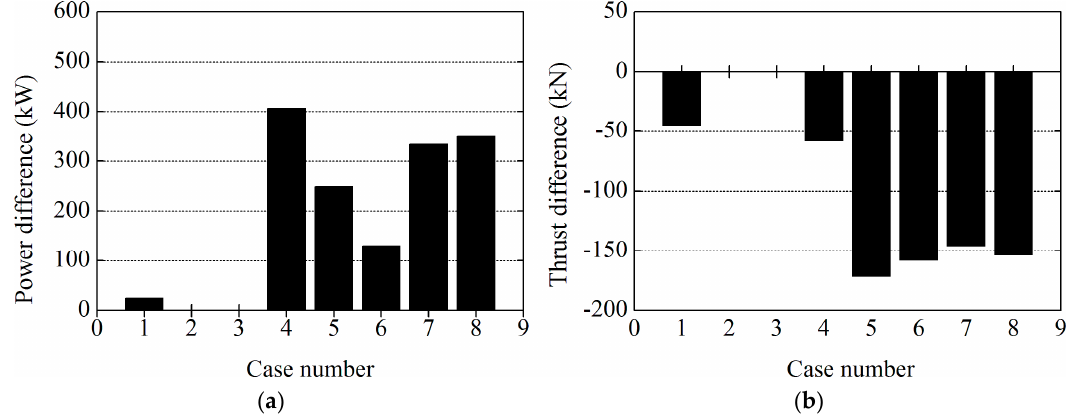
Figure 10. Comparison of di ff erent cases results in 11.4 m / s: ( a ) power; and ( b ) thrust Case 1: Elastic Actuator Line Model (present study); Case 2: NREL’s FAST code; Case 3: Horizontal Axis Wind turbine simulation Code 2nd generation results; Case4: research by Li et al. [17]; Case 5: research by Jeong et al. [30]; Case 6: research by Ponta et al. [31]; Case 7: research by Yu et al. [32,33]; Case 8: research by Ma et al.